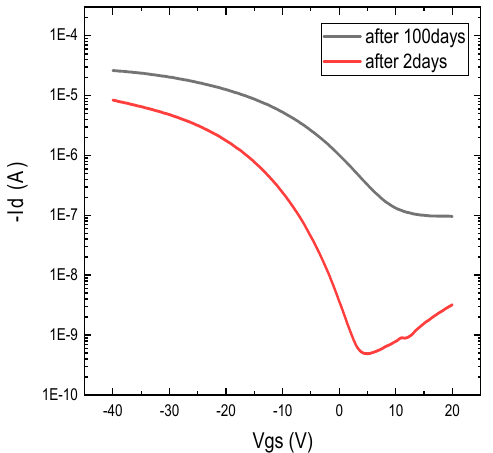
Figure 10. Transfer characteristics of printed device with 2:1 wt. ratio of PVP to PMF after 2 days and 100 days of device printing without encapsulation .